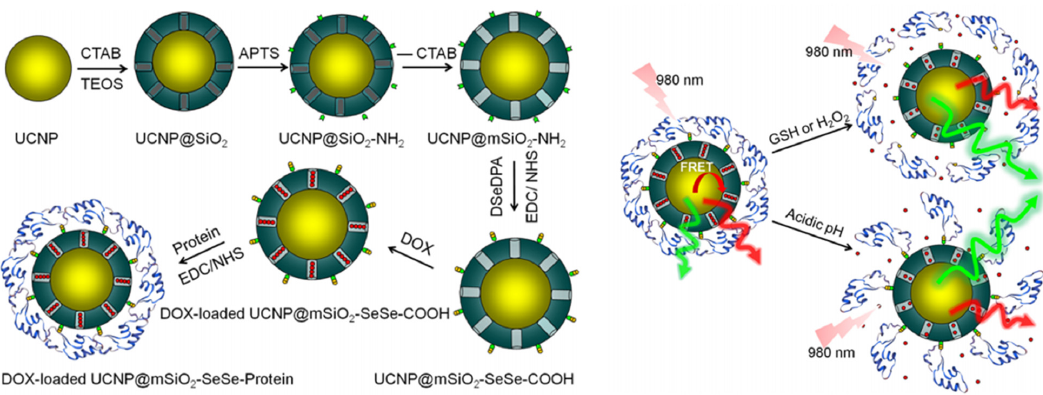
Figure 9. Creation of nanovehicles of protein-gated UCNP@mSiO 2 via Se − Se linkages to track drug release in real time in response to several stimuli. Reproduced with permission from Ref. [122], Copyright 2021, American Chemical Society.